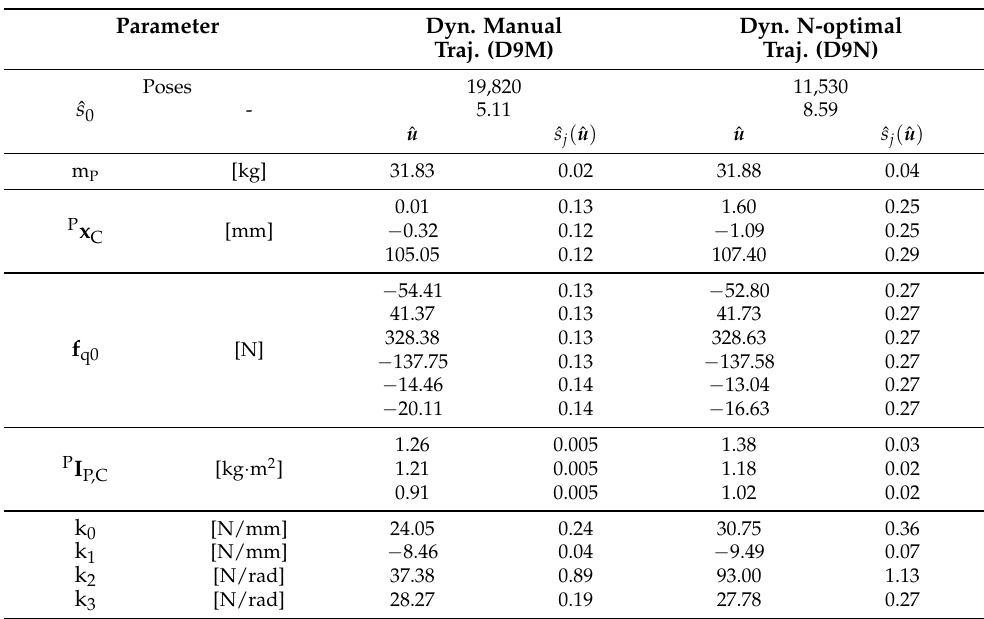
Table 6. Identification results using model 9 for dynamic measurements with manually created and optimised Fourier series trajectory, compare Figure